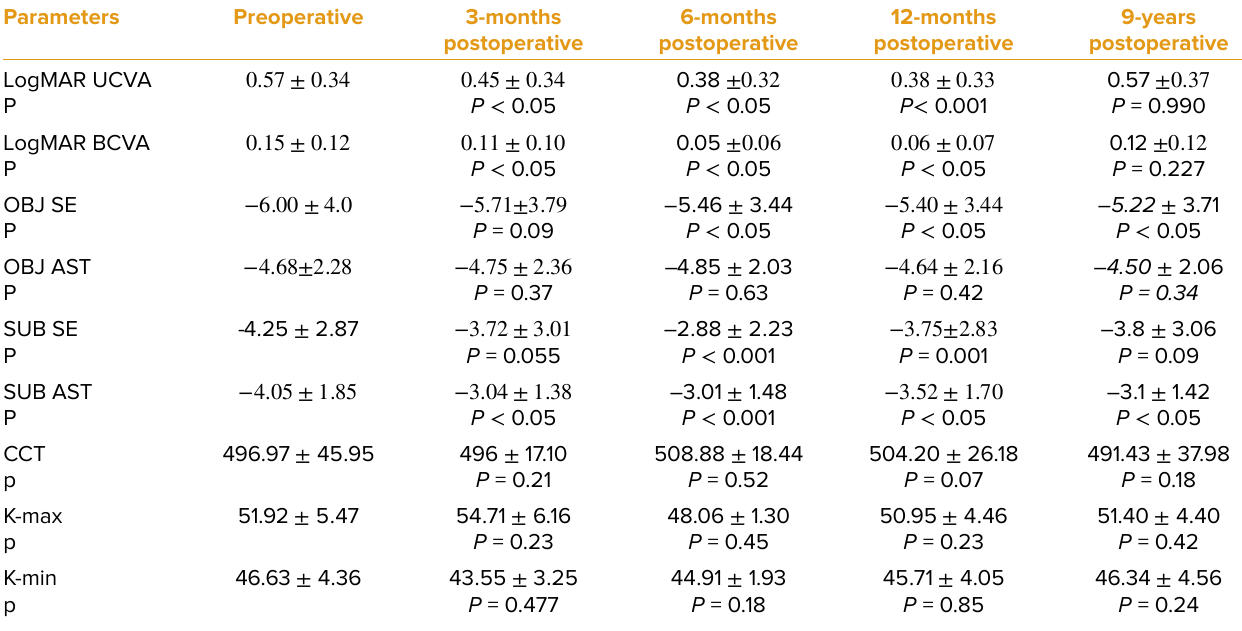
Table 1. Preoperative and postoperative patient